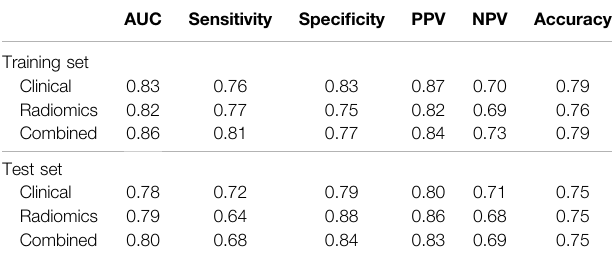
TABLE 6 | Comparison of diagnosis ef fi ciency between clinical model and radiomics model.